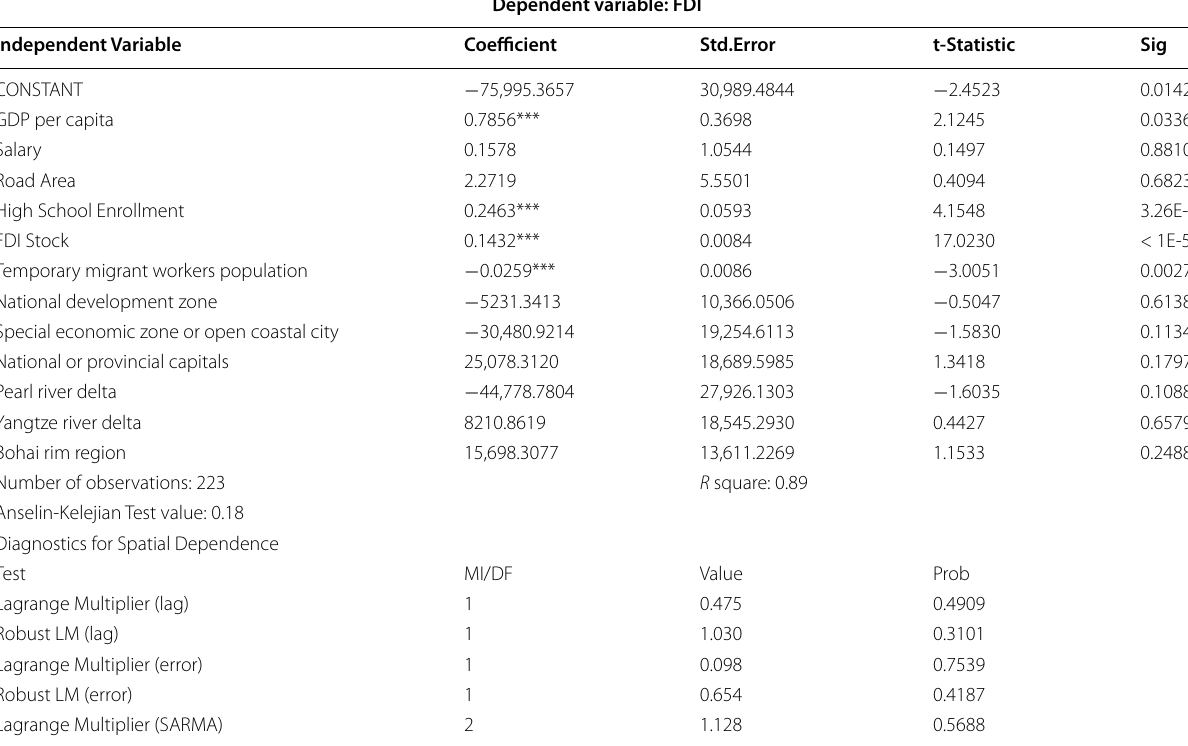
Dependent variable: